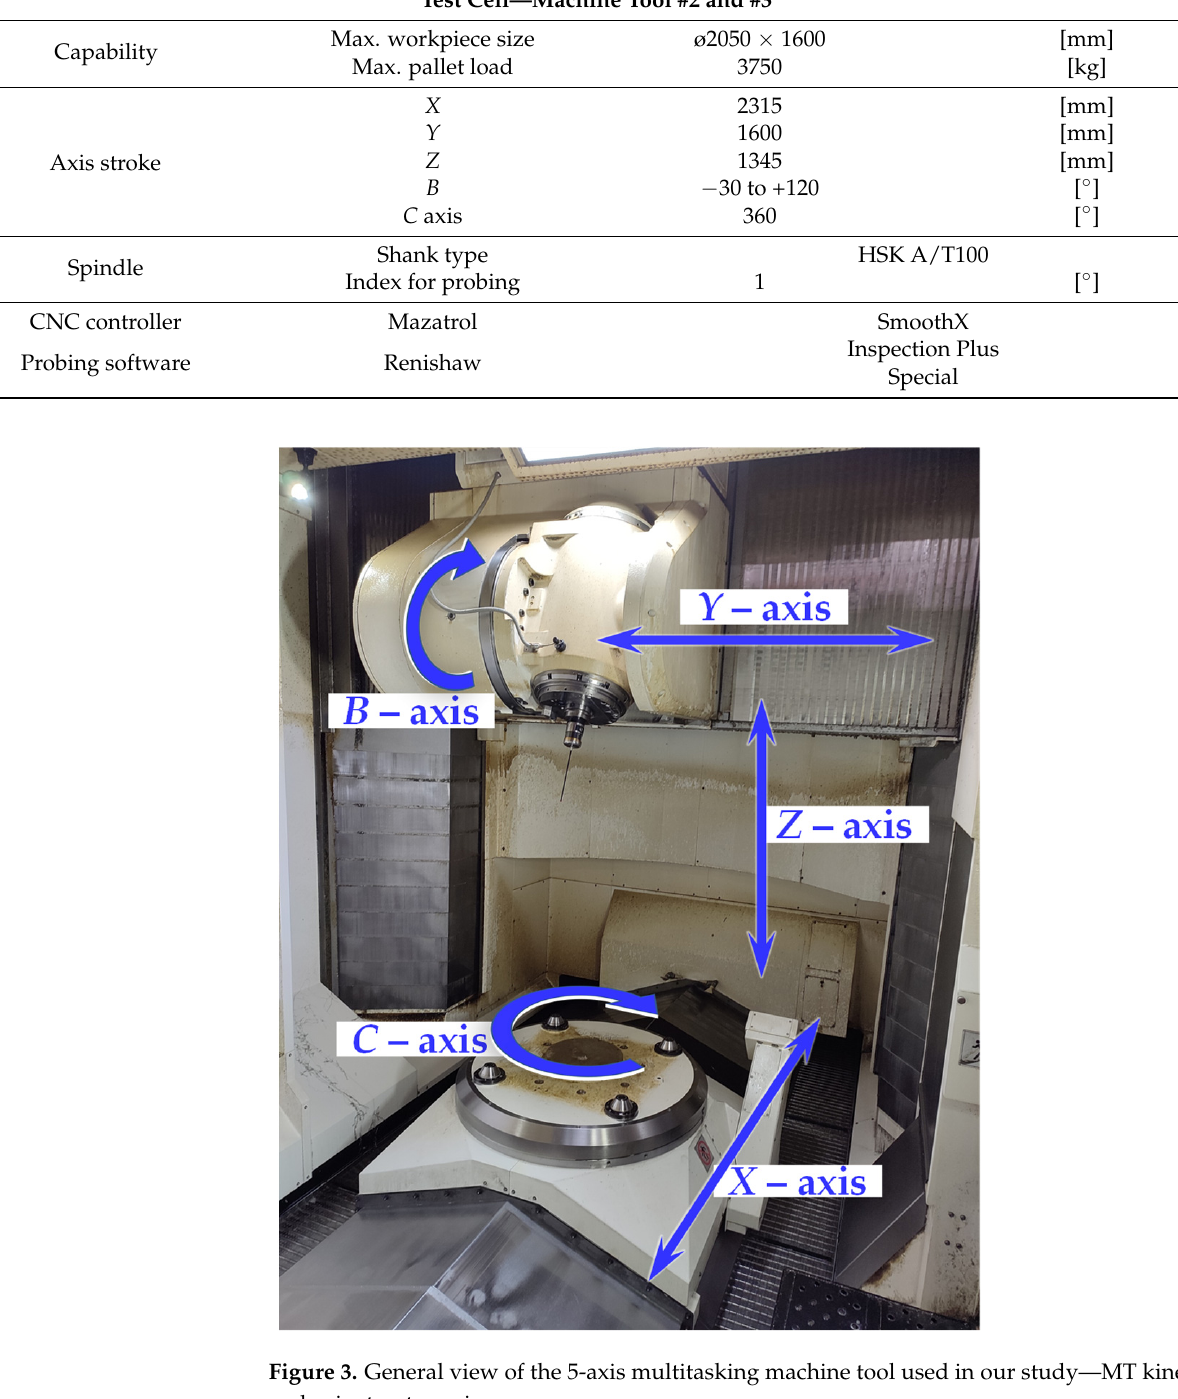
Table 1. General scope of the 5-axis multitasking machine tool used in our study—MT specification outline. Test Cell—Machine Tool #2 and #3